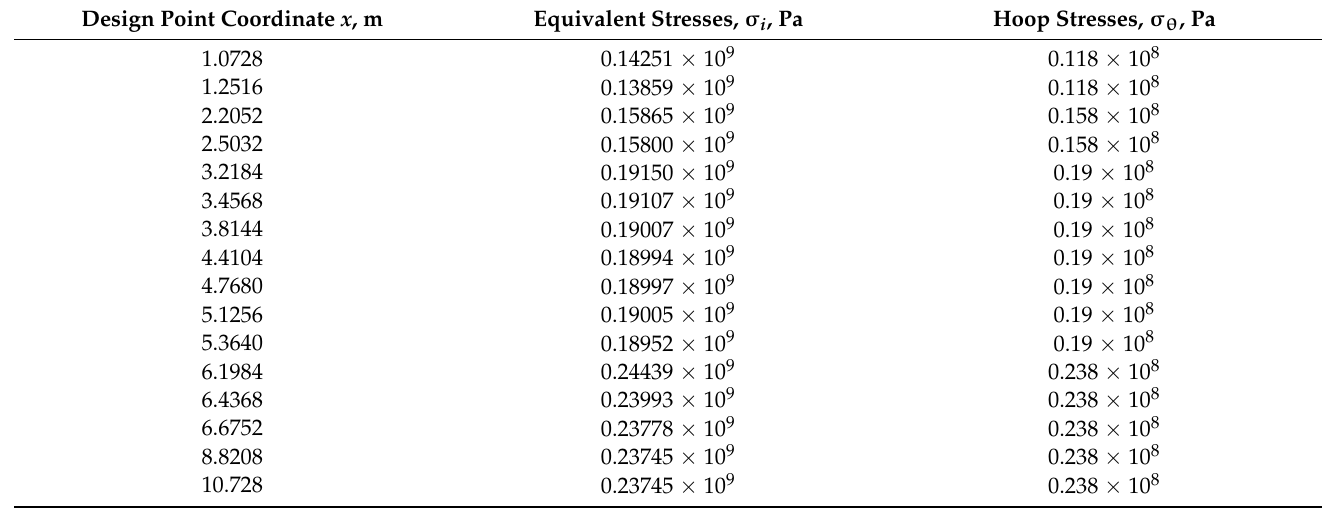
Table 2. The results of comparing the equivalent σ i and hoop σ θ stresses of the middle shell